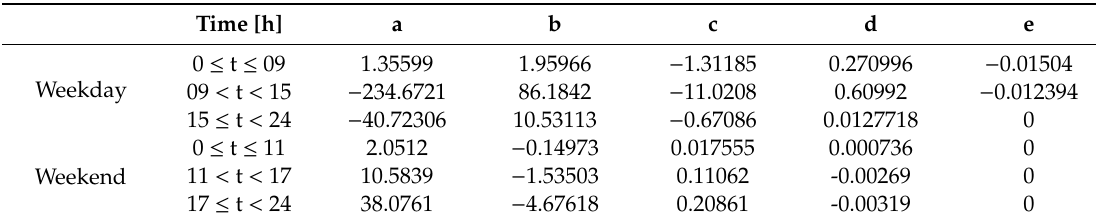
Table 4. Interpolation coefficients for the structural dataset formula: E [W/m 2 ] = a + bt + ct 2 + dt 3 + et 4 , t ϵ [0,24).